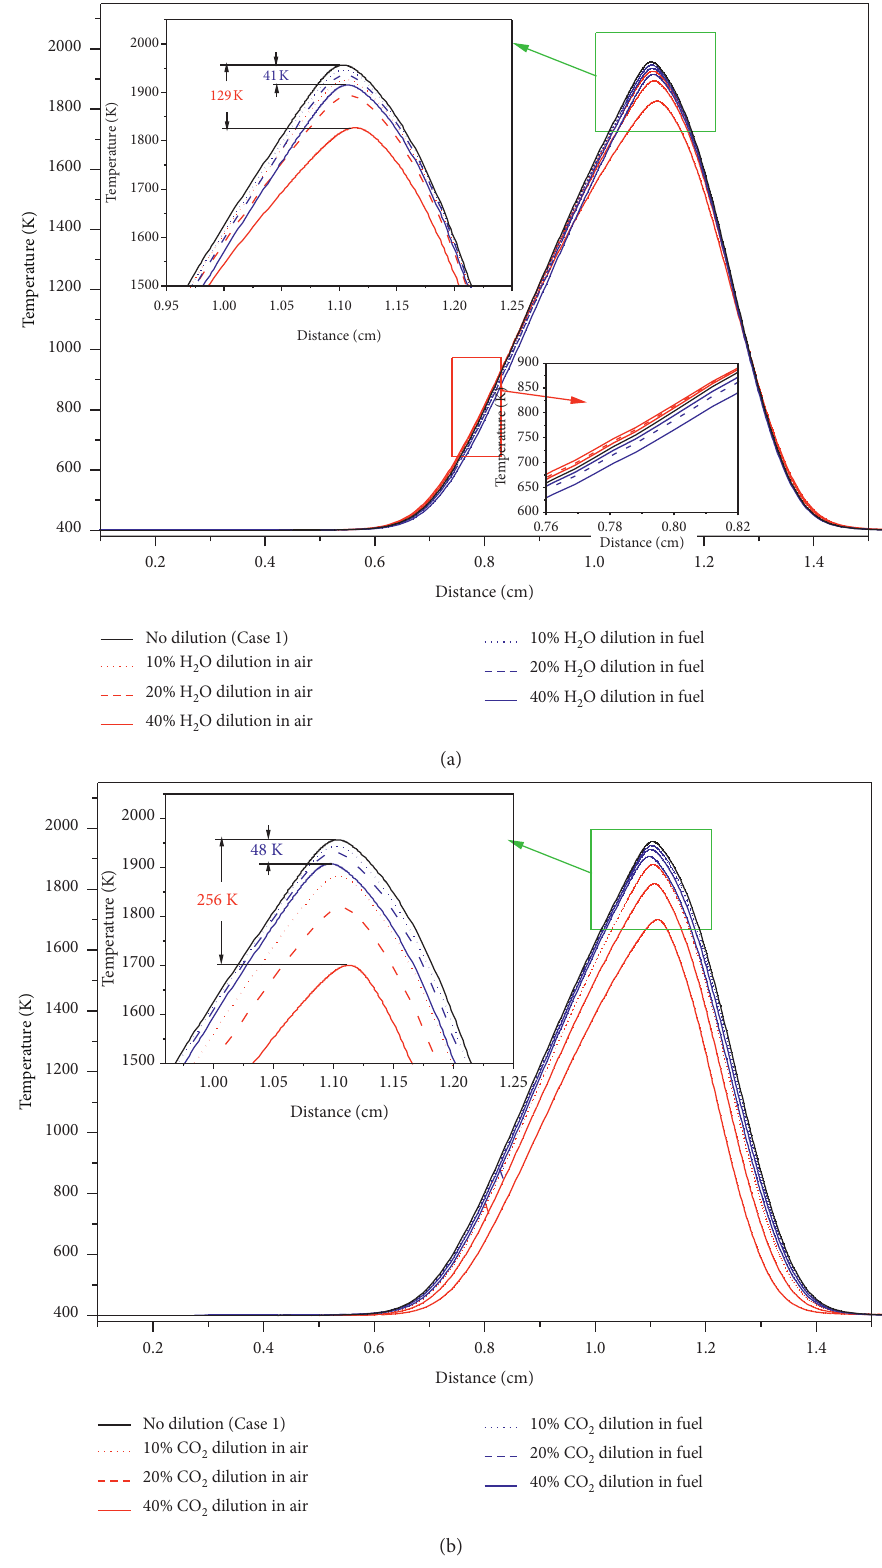
Figure 3: Distributions of flame temperature in CH 4 /air counterflow diffusion flames with (a) H 2 O dilution and (b) CO 2 dilution as a function of distance from the fuel nozzle: a s � 50s − 1 , L � 2cm,